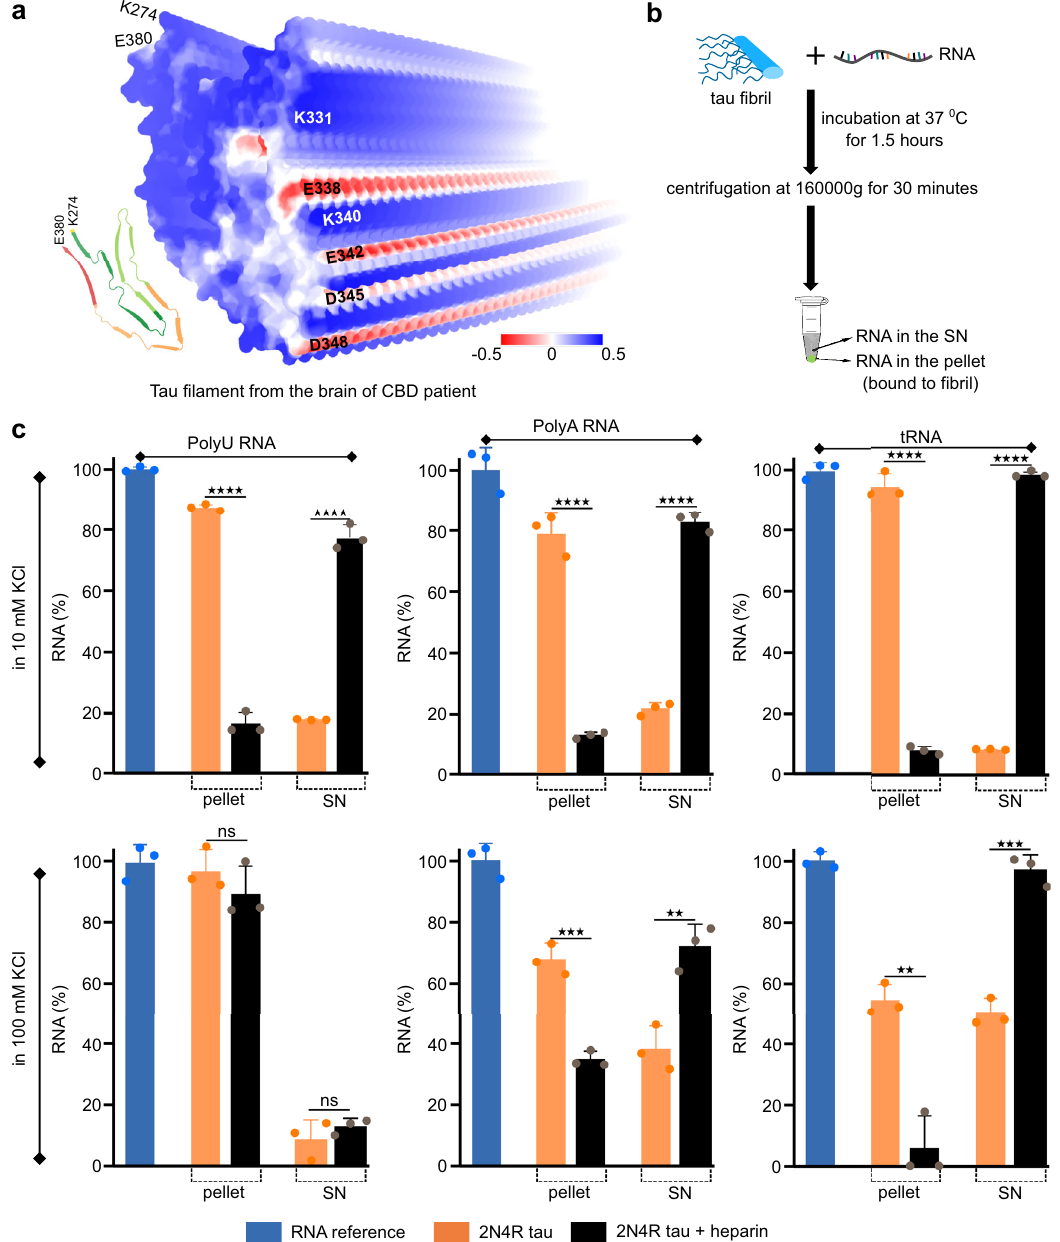
Fig. 6 Heparin-free tau fi brils strongly bind RNA. a Electrostatic surface potential of the tau fi lament extracted from a CBD patient (PDB code: 6TJO). Positively and negatively charged residues are shown in blue and red, respectively. b Schematic representation of the protocol to determine the binding of RNA to tau fi brils. c Quantitative analysis of the binding of polyU, polyA and tRNA to tau fi brils aggregated without (orange) or with heparin (black) in the aggregation assay buffer (10 mM KCl, 25 mM HEPES, 5 mM MgCl 2 , 3 mM TCEP, pH 7.2) or at increased ionic strength (100 mM KCl, 25 mM HEPES, 5 mM MgCl 2 , 3 mM TCEP, pH 7.2). The amount of RNA in the pellet represents the % of RNA bound to the fi bril and the amount of RNA in the supernatant (SN) represents the % of unbound RNA. The statistical analysis between the % of RNA bound to heparin-free and heparin-induced tau fi brils was performed by Welch ’ s t test. Four stars represent p < 0.0001, three stars represents p < 0.0002, two stars represents p < 0.0021. Data are represented as mean values of n = 3 independent experiments. Error bars represent the standard deviation of three independent pellet (Fig. 6c). In contrast, only ~18% polyU, ~15% polyA and the absence of heparin, interacted with all three RNAs (Fig. 6c). ~7% tRNA were found in the pellets of the heparin-induced fi brils (Fig. 6c) suggesting very weak af fi nity of all three RNAs to suggested that polyU binds most ef fi ciently to the fi brils the heparin-induced fi brils in the aggregation assay buffer. (Fig. 6c). In the case of the heparin-induced 2N4R tau fi brils, ~90% polyU, ~35% polyA and ~6% tRNA was detected in the pellet. The heparin-induced fi brils thus bind to polyU in 100 mM KCl, but hardly interact in this condition with tRNA (Fig. 6c).